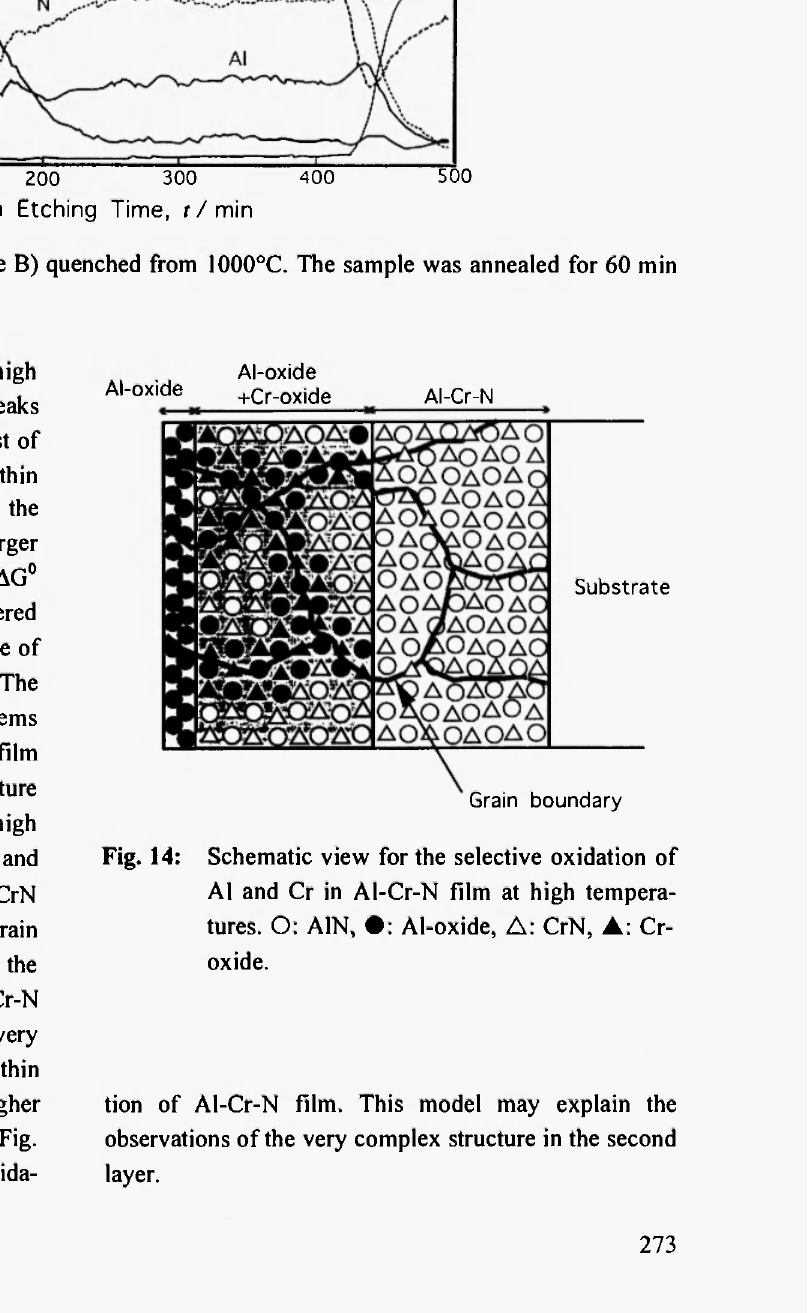
Fig. 13: Auger depth profile of Al-Cr-N film (Type Β) quenched from 1000°C. The sample was annealed for 60 min in air.